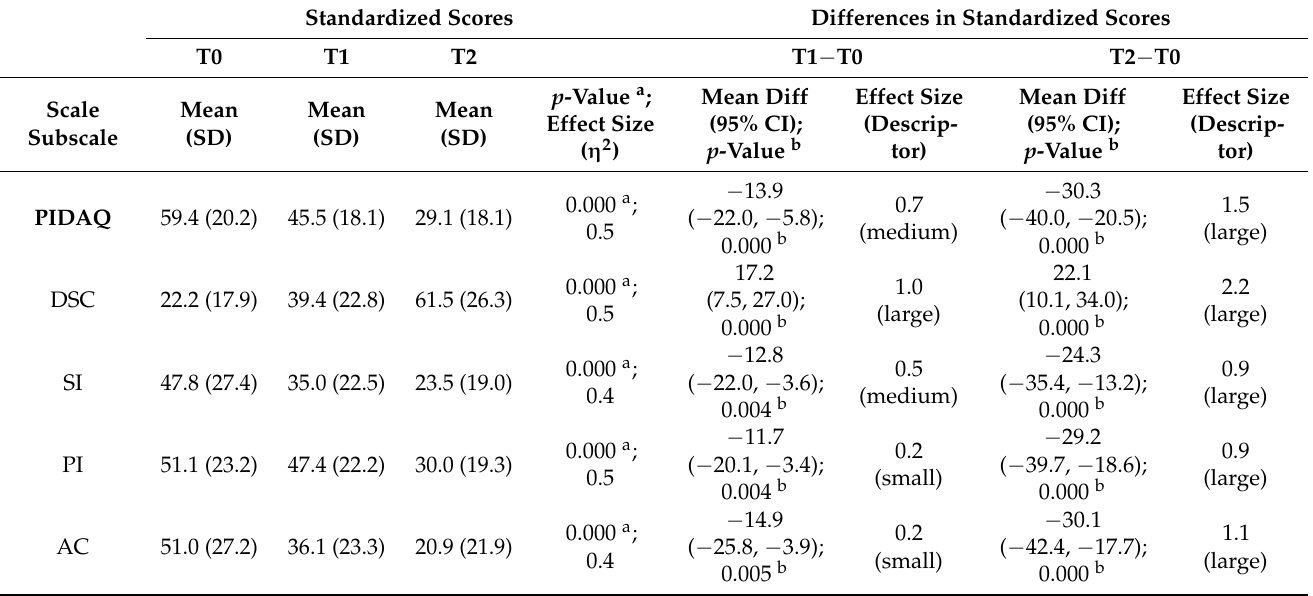
Table 2. Changes in standardized Malaysian psychosocial impact of dental aesthetics questionnaire (PIDAQ) scores ( N = 37).